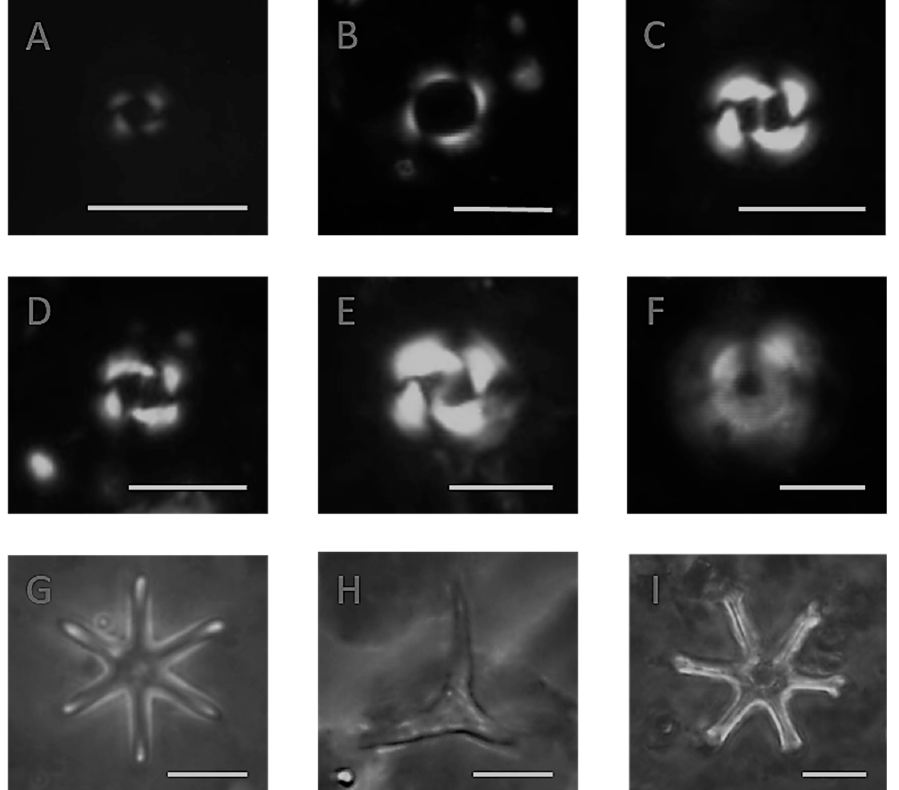
Figure 4. Photomicrographs of calcareous nannofossil marker taxa used in subdividing the uppermost Pliocene and Pleistocene. All specimens are photographed under 1000× magnification. Abbreviations listed: XPL = cross-polarized light image. PC = phase contrast image. ( A ) Emiliania huxleyi ,